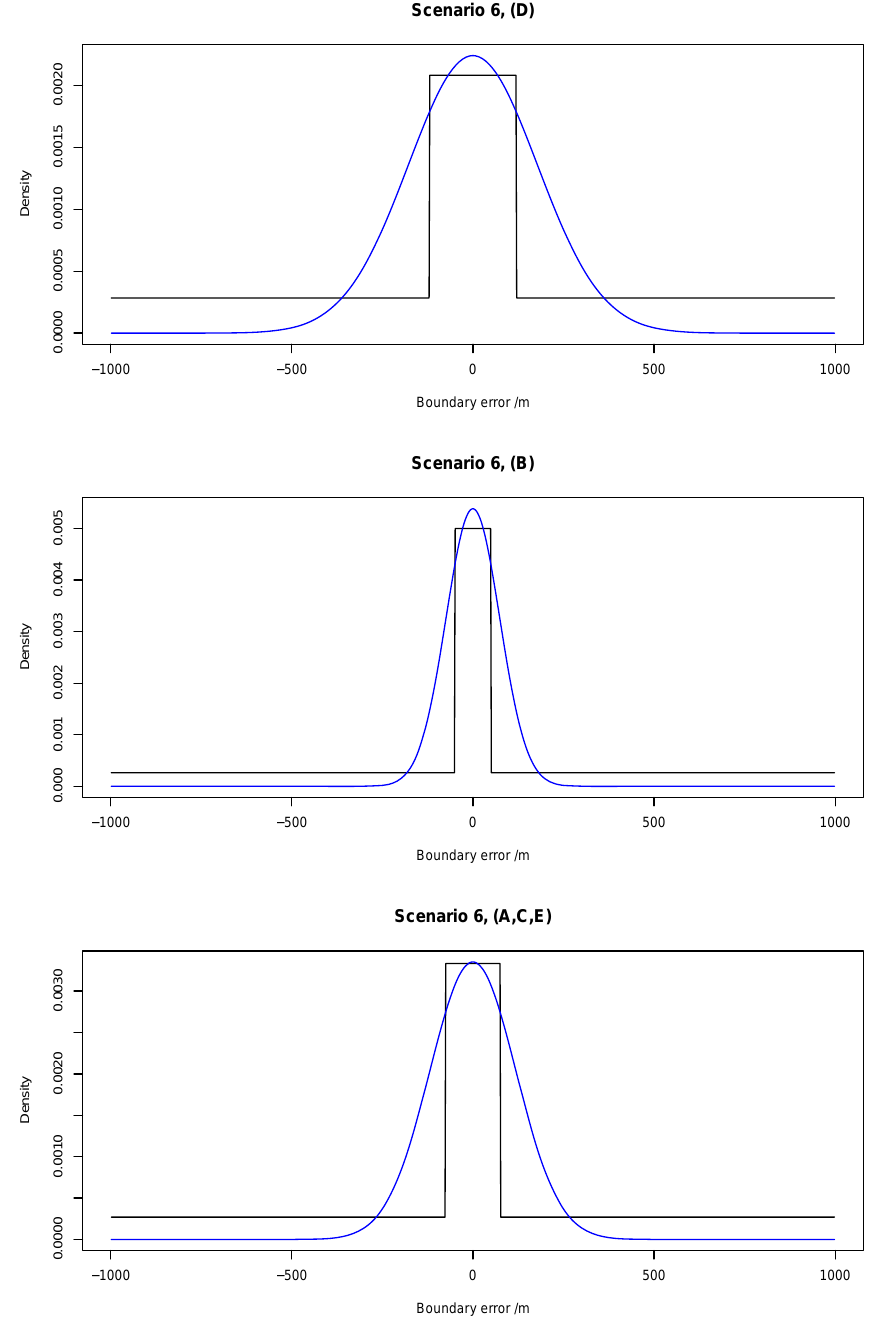
Figure 5. Best-fitting distributions for quartiles of scenario 6 according to three expert subgroups (letters are expert codes). Solid black line shows uniform density over elicited interquartile ranges, blue line show best-fitting